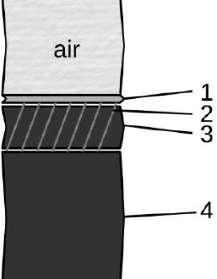
Fig. 5. Scheme of heating wall layers in the channel by of Hwang et al. 1 polished and black lacquered aluminium sheet, 2 Ni-Cr resistance wire, 3 asbestos plate, 4 asbestos thermal insulation.